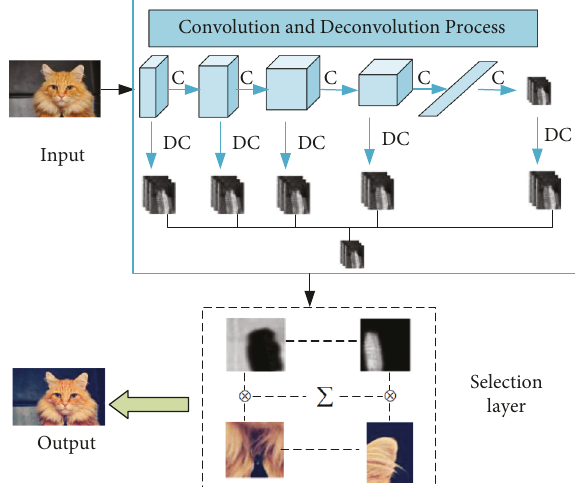
Figure 5: The application of neural networks in image